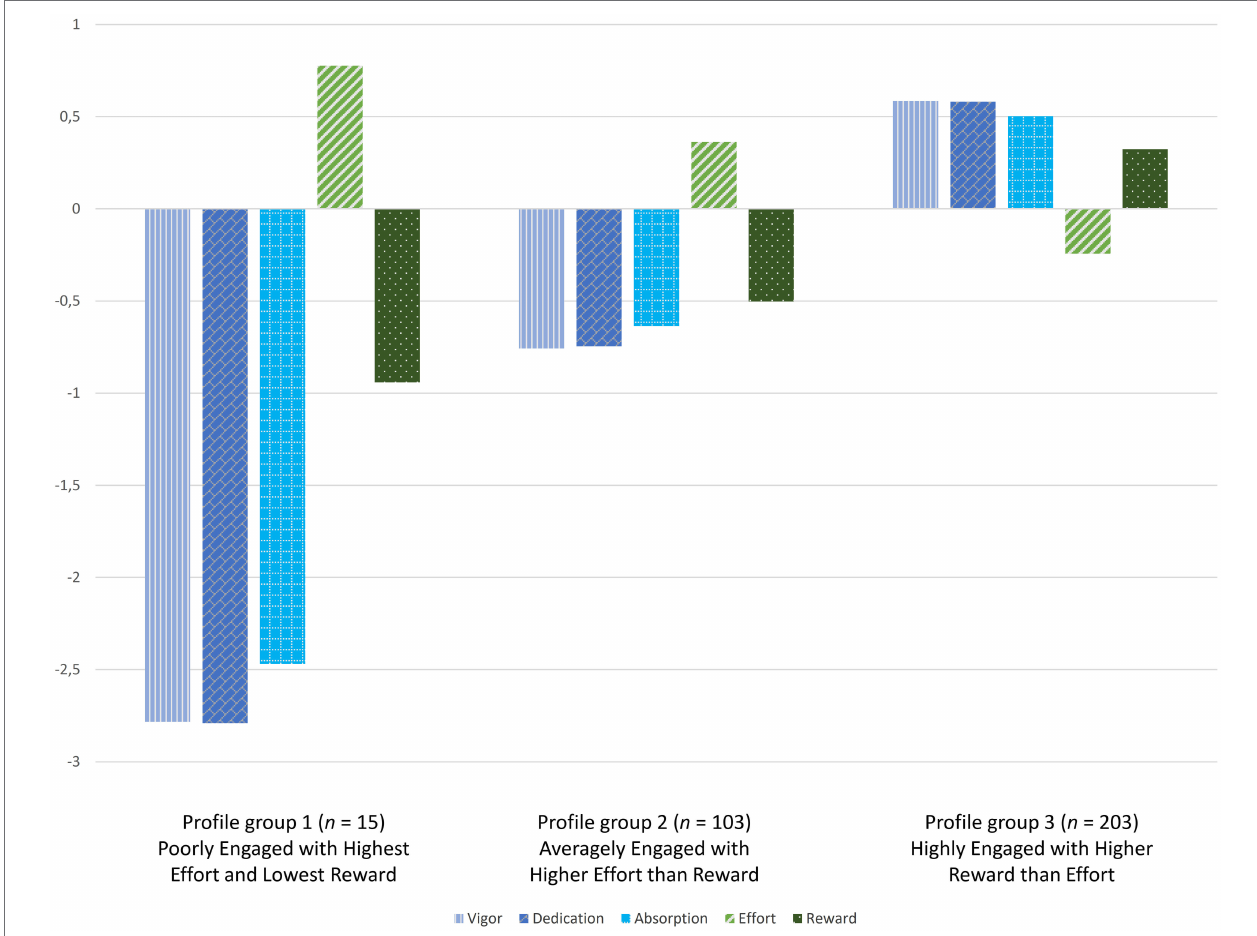
FIGURE 1 | The three-profile groups based on work engagement and work-related effort and